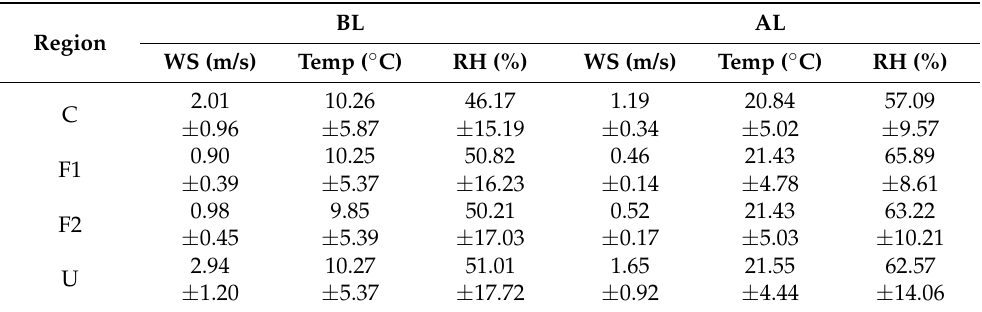
Table 2. Meteorological conditions at two willow forests in Yeouido Saetgang Ecological Park during the study